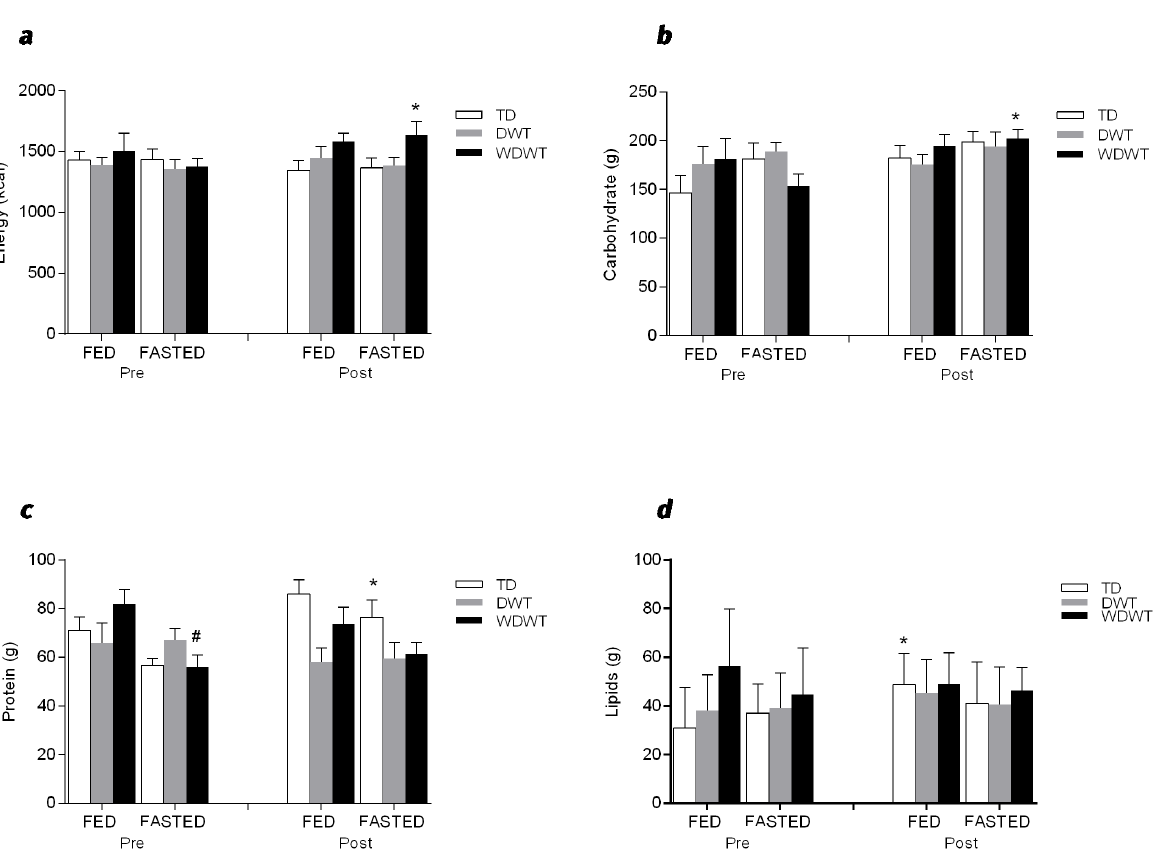
Figure 2. TD: training day; DWT: day without training; WDWT: weekend day without training. Two-way ANOVA for repeated measurements. Data presented as mean ± standard deviation. p <0.05. *against pre in the same group. # against fed at the same